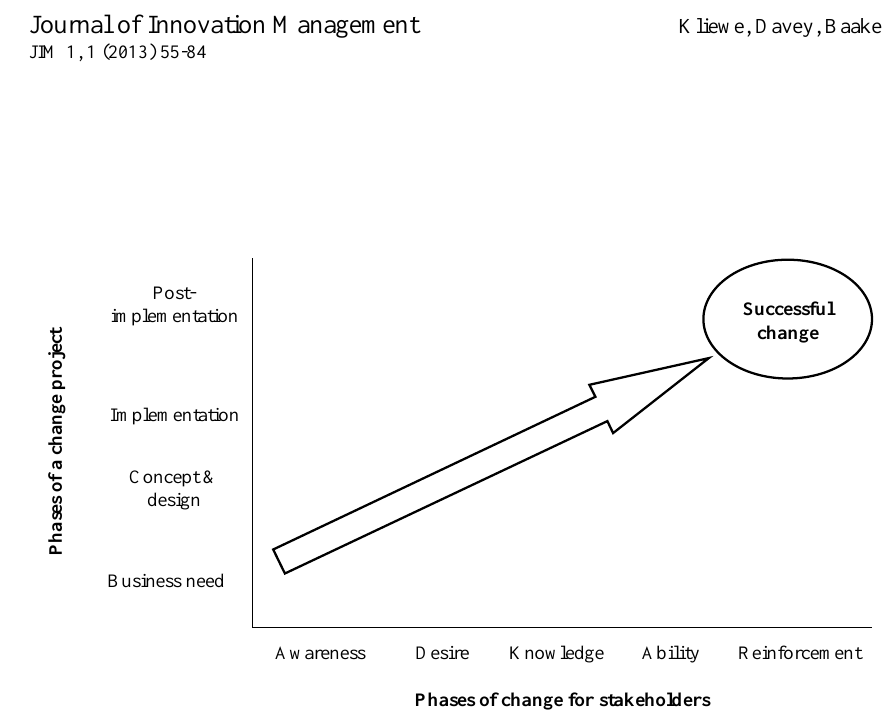
Fig. 2. The ADKAR model (following Hiatt, 2006, p.59)